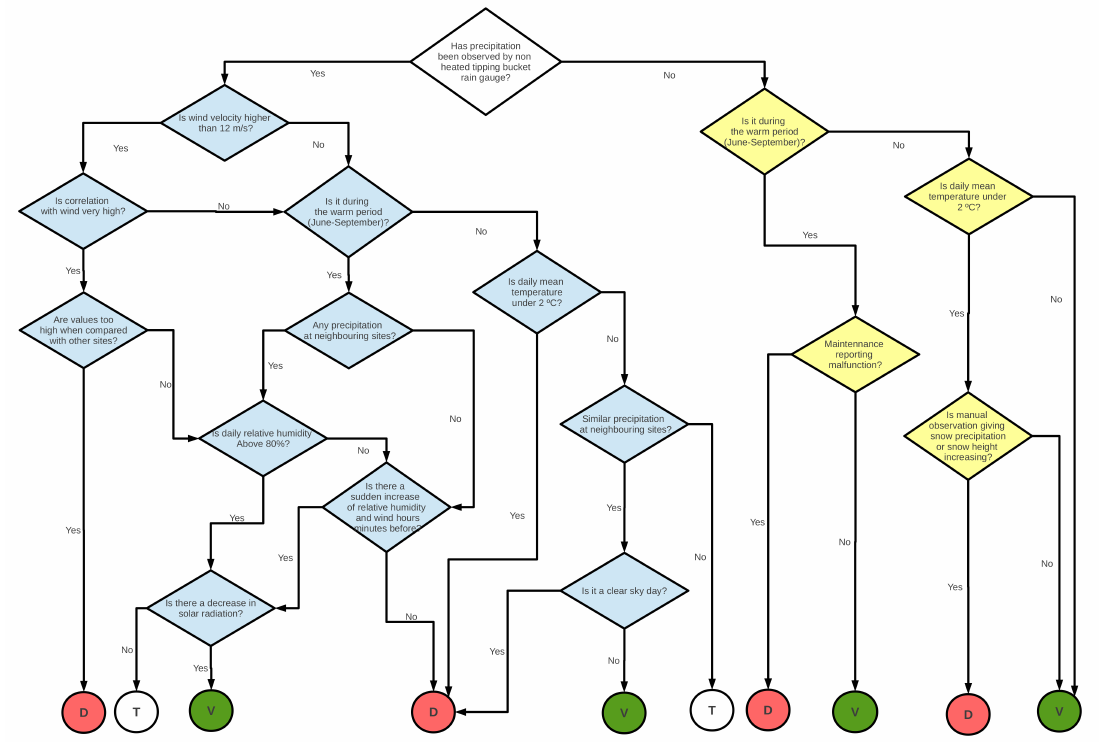
Figure 14. Guidelines for precipitation validation. “V” means data with a high probability of being valid. “D” means data with a high probability of not being valid. “T” means data with an incoherent behavior with other variables (internal consistency) or other sites (spatial consistency) and which deserve further research elevations of the zero isotherm for winter months calculated out of the temperatures observed at all